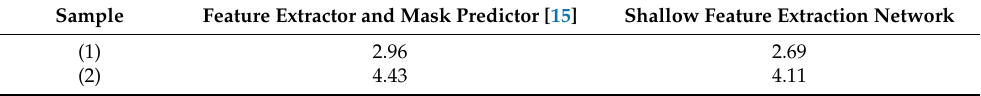
Figure 13. Ablation experiments. Feature extractor and mask predictor [15] and w/o. Shared weight are ablation experiments for shallow feature extraction networks. Unet [38] and ResNet-34 [39] are ablation experiments on generator backbones.